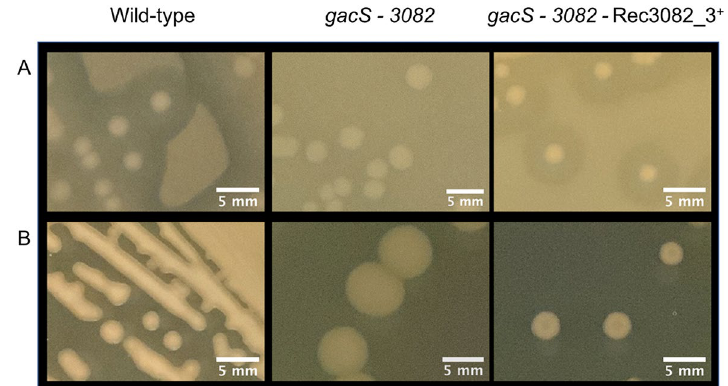
Figure 5. GacS chimeras perform both intra- and intermolecular phosphotransfer. Restoration of the wild- type strain phenotypes by expression of 3082_3 + chimera in the gacS — 3082 double mutant, compared to the